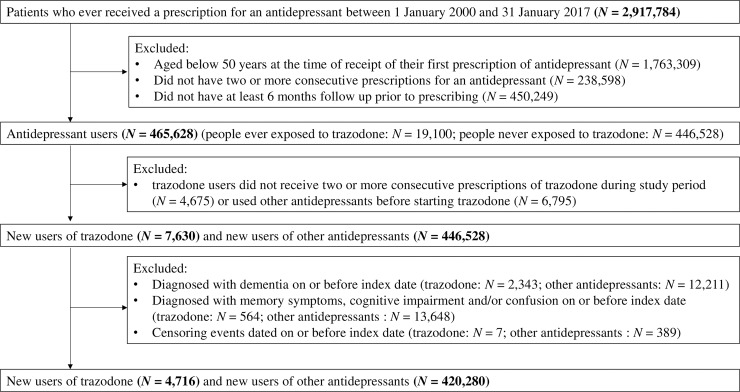
Flow of patients.